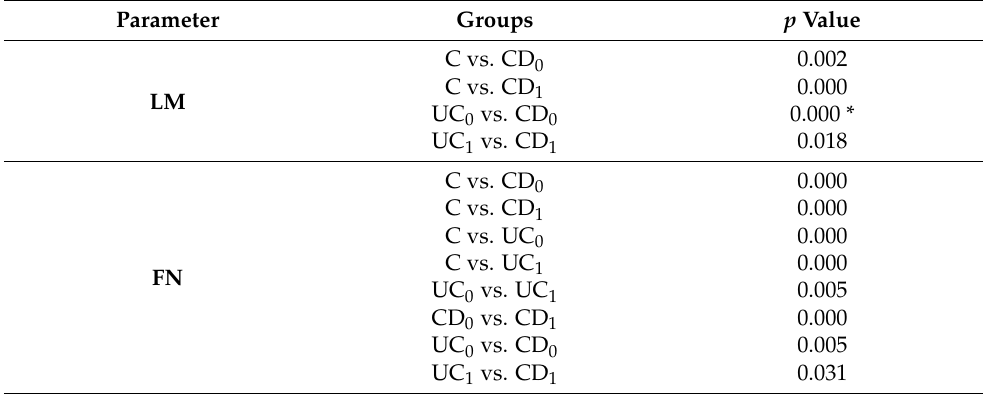
Table 4. Statistical significance of changes in serum laminin (LM), fibronectin (FN) and neutrophil gelatinase-associated lipocalin (NGAL) concentrations between analyzed